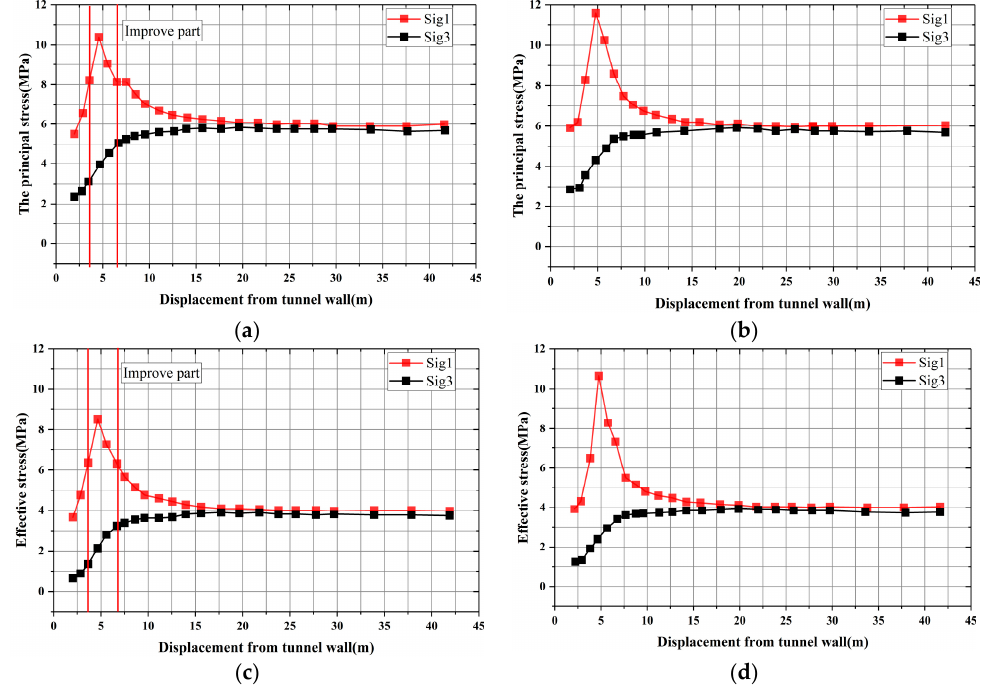
Figure 10. Stress distribution in a horizontal line. ( a ) The total stress in Case 1; ( b ) the total stress in Case 0; ( c ) the effective stress in Case 1; ( d ) the effective stress in Case 0. (Sig1: the major principal stress; Sig3: the minor principal stress.)